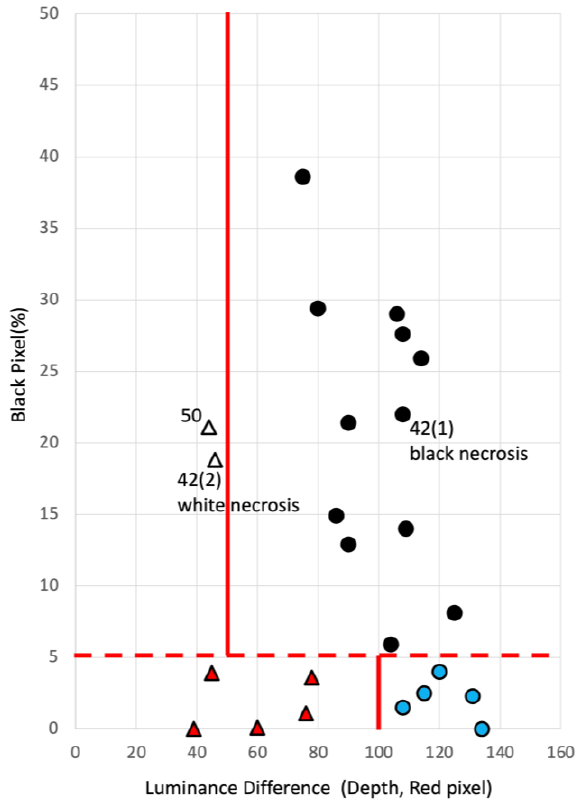
Figure 5. 23 cases aligned on the chart for detection of wound depth. The patients were divided into four groups based on physician judgment: no necrosis and shallow wound (red triangle), necrosis and shallow wound (white triangle), necrosis and deep wound (black circle), and no necrosis and deep wound (blue circle). The presence or absence of necrosis is separated into two categories by the line of 5% black pixels on the plane of white and black pixels. All pixels above 5% are classified as “necrotic” by the algorithm. This result is consistent with the judgment of the specialist physicians. Table 7. The validation of determination of wound depth with medical specialists vs. image identi- fication algorithm. Diagnosed by Image Identification Algo- rithm With Necrosis No Necrosis With necrosis 17 0 Diagnosed by medical specialists No necrosis 0 7